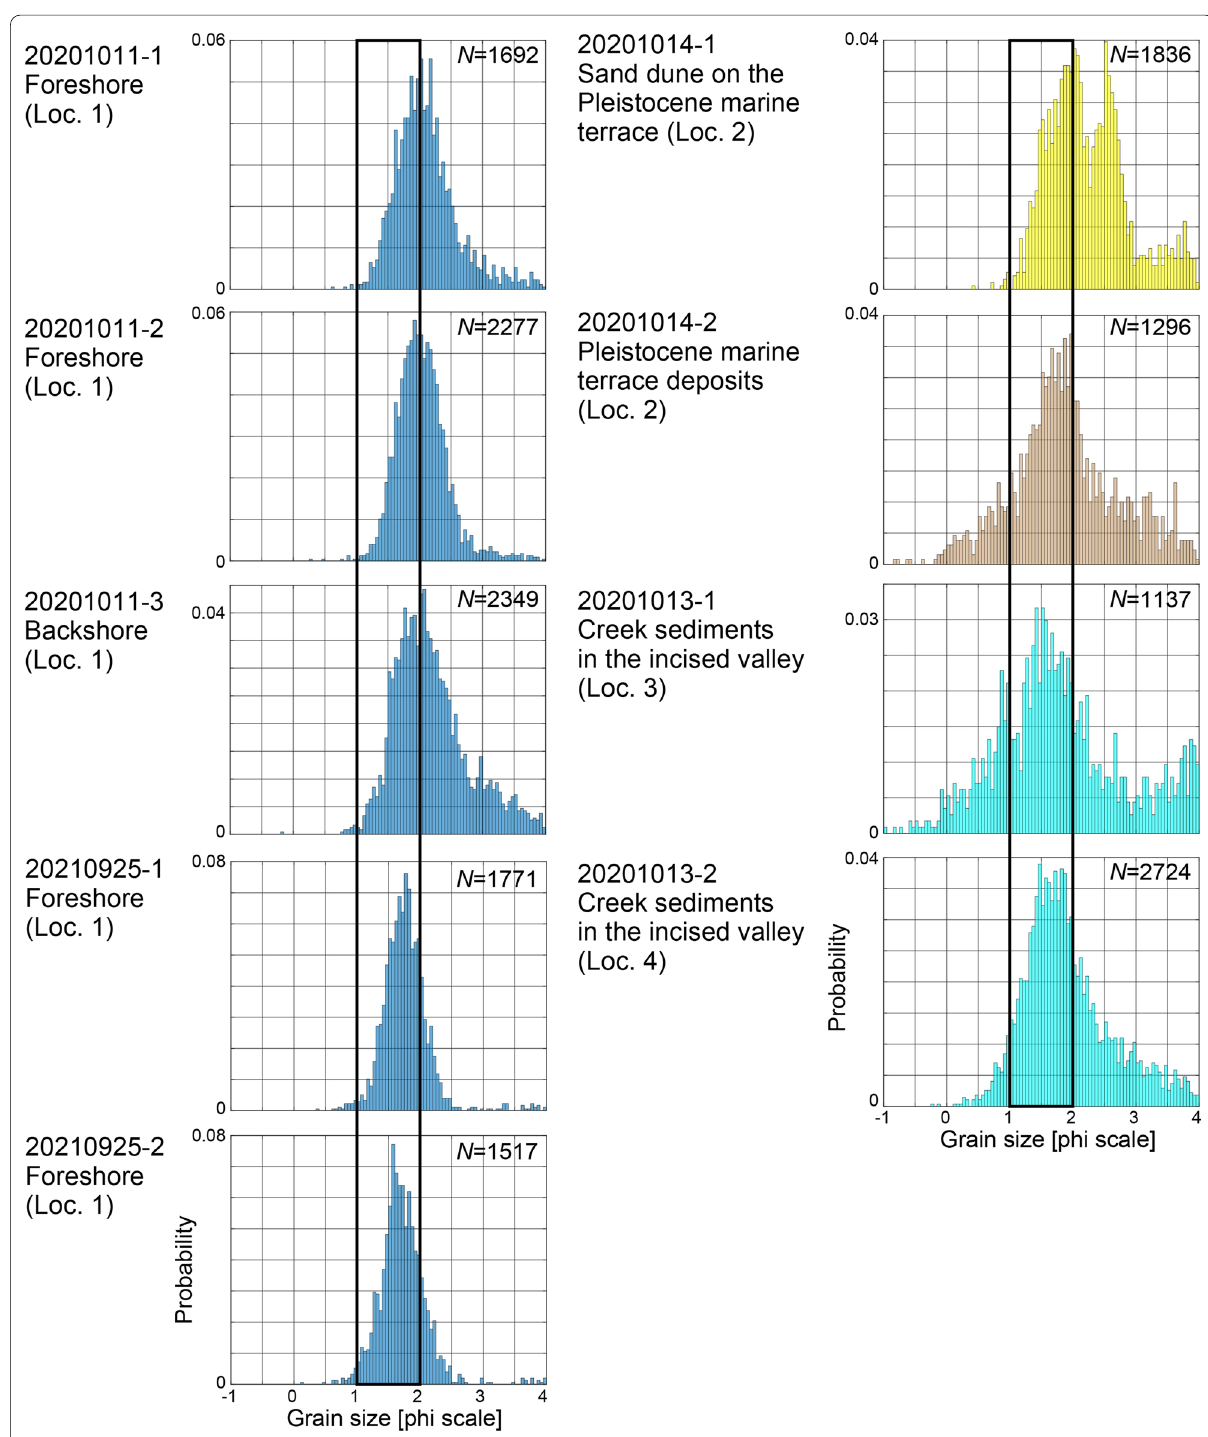
Fig. 9 Grain-size analysis of present-day sediments. Histograms show phi-scale grain-size distribution. Vertical axis indicates the probability of particles. N means the number of particle samples measured. Mean, median, mode, skewness, and kurtosis of each histogram are shown